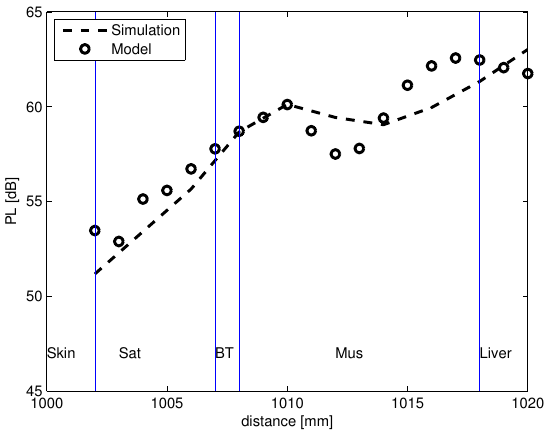
Figure 8. Simulated PL in the heterogeneous human Duke and PL model versus the separation distance between